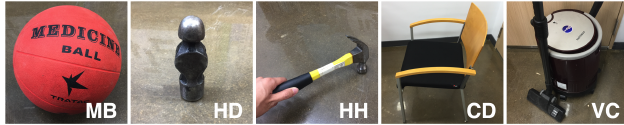
Figure 1. Five noise types included in the inter-floor noise